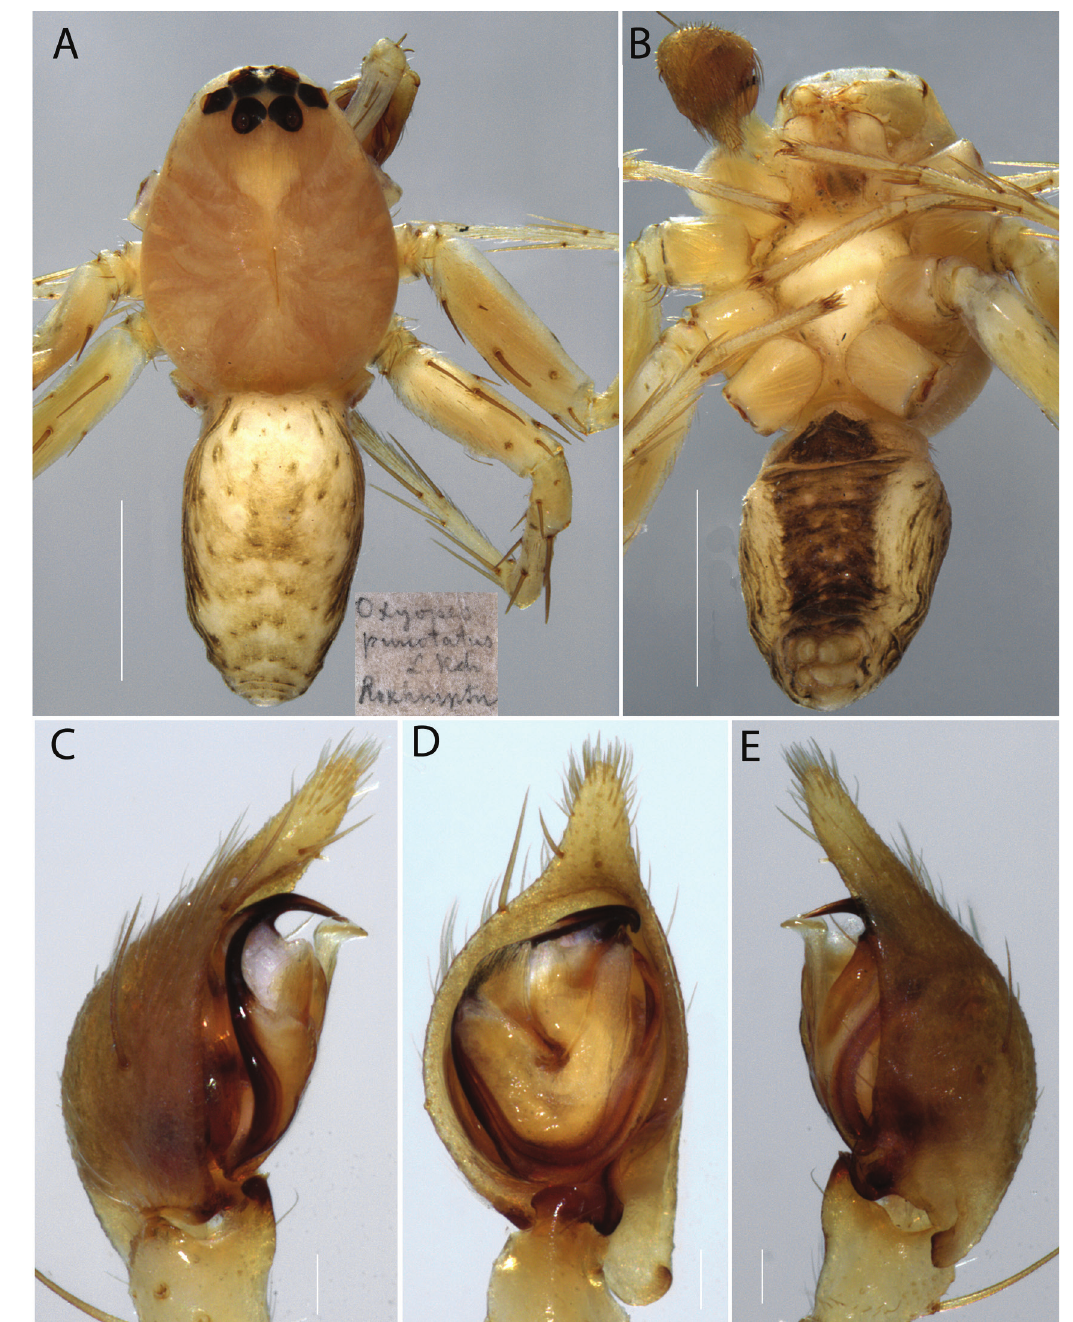
Figure 13. Oxyopes punctatus L. Koch, 1878, male lectotype (ZMH- A0000017): A , habitus, dorsal view; B , habitus, ventral view; C, male palp, prolateral view; D, same, ventral view; E , same, retrolateral view;. Scale bars: habitus 1.0 mm, palp 0.1 mm.